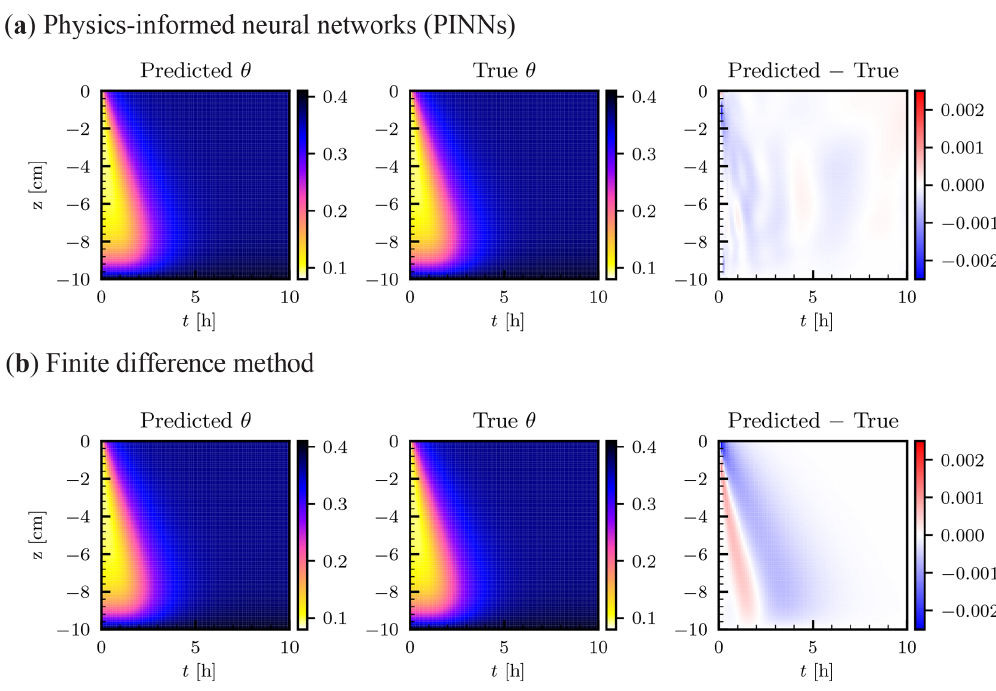
Figure 3. Homogeneous soil. (a) Physics-informed neural network (PINN) solution in terms of volumetric water content θ [–] (left column). The neural network consisted of five hidden layers with 50 units with the layer-wise adaptive activation function. True analytical solution (center column) is given by Srivastava and Yeh (1991) (see Sect. 2.2.1), and the difference between the PINN and true solutions is shown in the right column. (b) Numerical solution by a finite difference method with a spatial mesh of d z = 0 . 1cm and a time step d t = 0 .